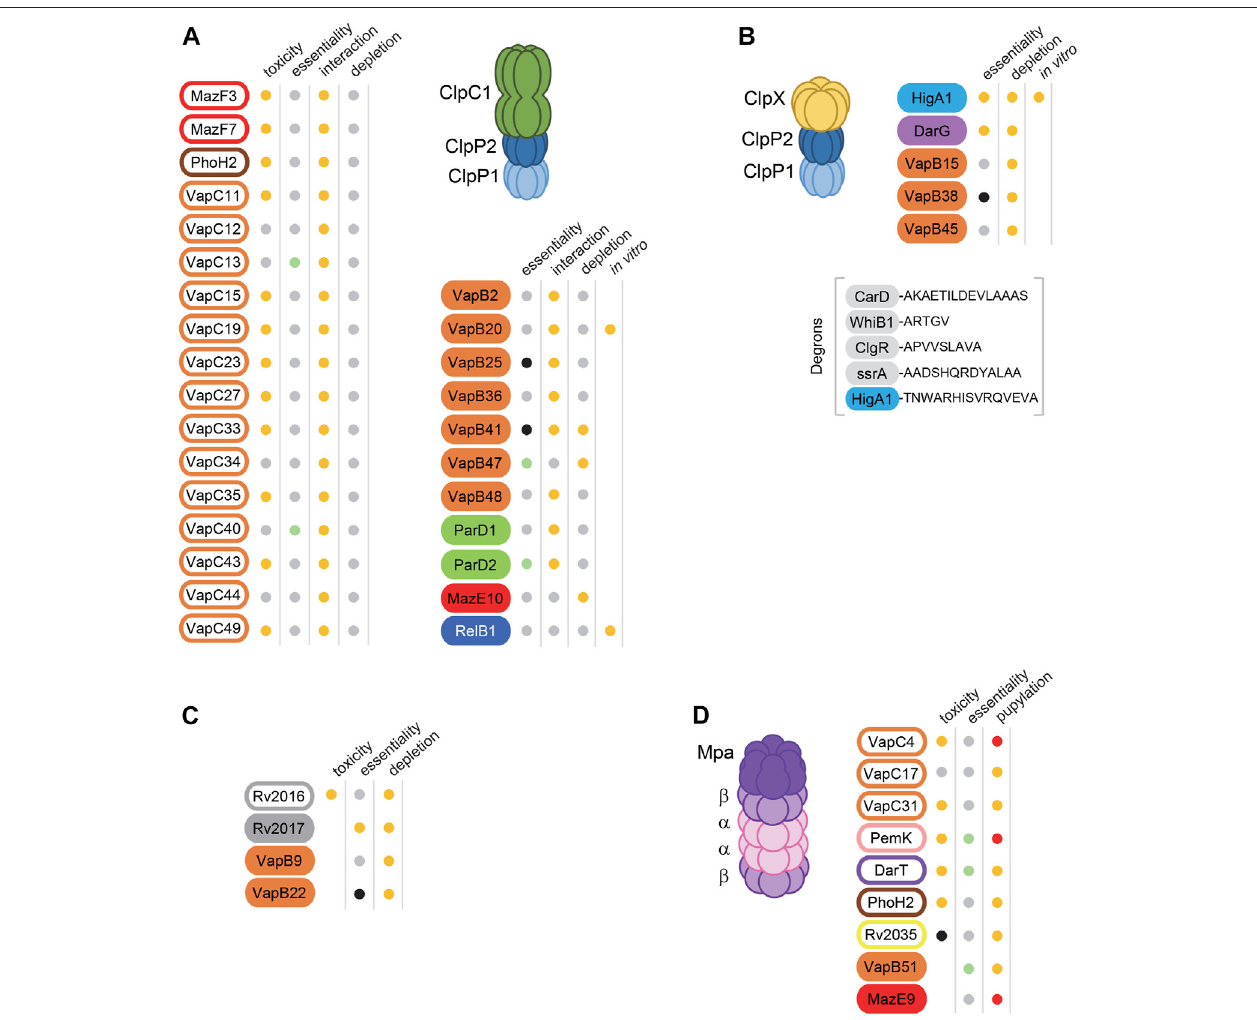
FIGURE1| ProteolyticregulationandrecognitionofToxin-Antitoxinsystemsin M.tuberculosis .TAfamiliesareindicatedbydifferentcolorsasfollowed:Orangefor VapBC, Green for ParDE, pink for PemIK, red for MazEF, dark blue for RelBE, purple for DarTG, bright blue for HigBA, brown for PhoAT-H2, yellow for ArsR-COG3832 and grey for unknown. Toxins and Antitoxinsare indicated by fi lled and open rounded rectangles,respectively. Toxin and Antitoxin proteins arecandidate substrates for proteases, (A) ClpC1P1P2 (B) ClpXP1P2, (C) ClpP1P2 (the associated chaperone subunit, either ClpX or ClpC1 is to be determined), (D) the Mpa-proteasome. KnowndegronsforClpXP1P2 areindicatedin (B) underbrackets. Functionalpropertieswereindicatedinthecolumns adjacenttothetoxinsand antitoxins, i.e .,toxicity, essentiality (essential), interaction, accumulation following protease depletion (depletion), in vitro degradation ( in vitro ) or pupylation. Toxicity: orange dots mean toxic when overexpressed (Ramage et al., 2009; Sala et al., 2014; Agarwal et al., 2018; Akarsu et al., 2019) in at least one bacterial host ( M. tuberculosis , M. smegmatis or E.coli ),greydotsnontoxicandblackdotnontested.Essentiality(DeJesusetal.,2017):orangedotsmeanessential,greendotsmeangrowthadvantagewhenmutated, grey dots non-essential, black dots mean uncertain or non-tested. Interaction with chaperone subunit ClpC1 in vivo (Ziemski et al., 2020): orange dots mean interaction and grey dots no interaction. Depletion of clpP1P2 , clpP2 or clpC1 (Raju et al., 2014; Lunge et al., 2020): orange dots mean protein stabilization and grey dots mean no detectable protein changes. In vitro degradation assays (Ziemski et al., 2020; Texier et al., 2021): orange dots mean degradation. Pupylation: orange dots mean pupylated under routine culture conditions (Festa et al., 2010), red dots mean pupylated by reconstituted system in E. coli and/or in vitro (Chi et al., 2018).